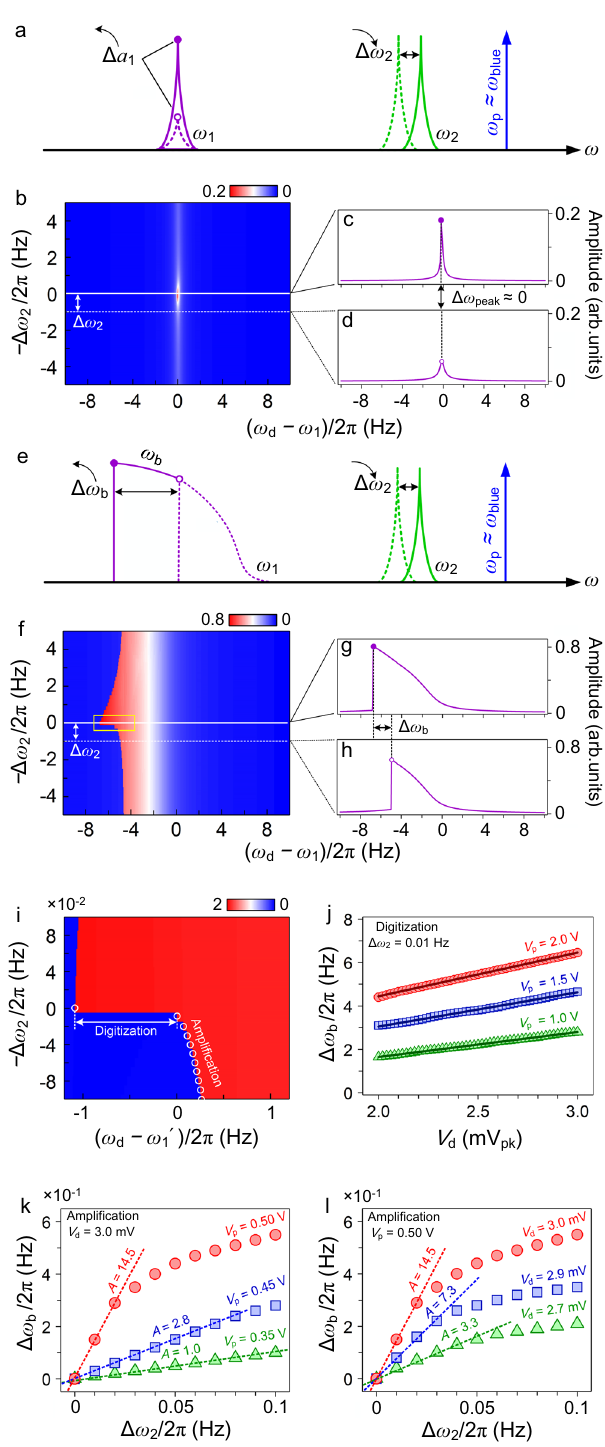
Fig. 4 Signal transduction and ampli fi cation in the 2-DOF phonon cavity system. a Schematic illustration of the phonon-cavity ’ s response (purple signal) to a shift in the input signal (green) under linear vibration, when the pump signal (blue) is aligned with the cavity ’ s blue sideband. b 2D color plot of the phonon-cavity ’ s response to the input perturbation under linear vibration. c , d Line plots taken from different operation points in b , showing a negligible shift in resonance peak frequency ω peak . e Schematic illustration of the phonon-cavity ’ s response (purple signal) to a shift in the input signal (green) under nonlinear vibration, when the pump signal (blue) is aligned with the cavity ’ s blue sideband. f 2D color plot of the phonon-cavity ’ s response to the input perturbation under nonlinear vibration. g , h Line plots taken from different operation points in f , showing a signi fi cant shift in ω b . i A zoomed-in view of the boxed area in f , illustrating the regions used for the two frequency-domain operations. j The output shift in ω b for a given input shift Δ ω 2 = 0.01 Hz as functions of V d , under different V p values. k The output shift in ω b versus input shift in ω 2 for different V p values. Larger V p corresponds to stronger parametric coupling. l The output shift in ω ω V V b versus input shift in 2 for different d values. Larger d corresponds to deeper nonlinearity. Plot details are provided in the “ Methods ”